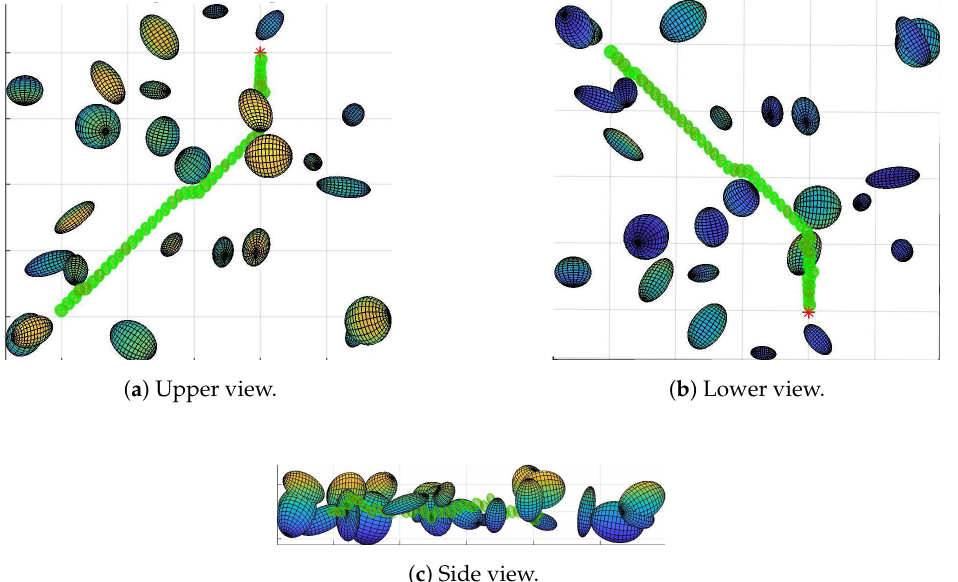
Figure 12. Path of map 4 generated with TLBO. The algorithm founds a smooth path in presence of convex